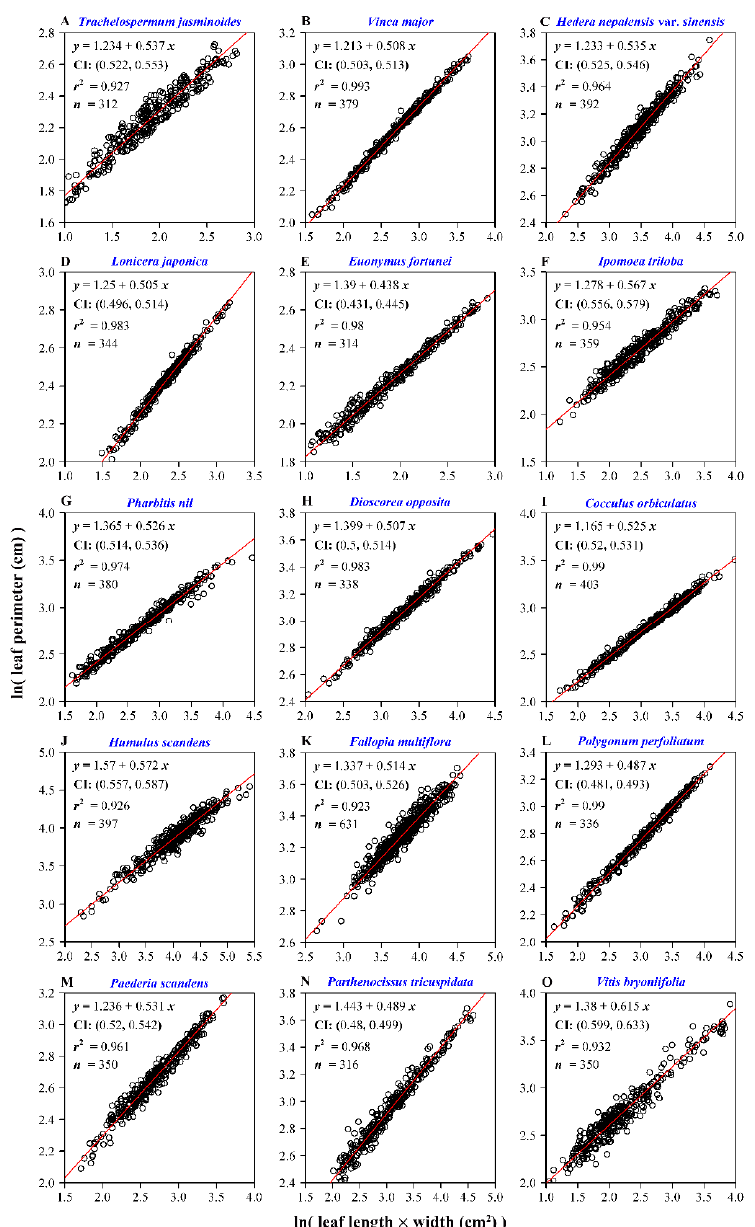
Figure 9. Scaling relationships between leaf perimeter and the product of leaf length and width for the 15 species of vines. Panels ( A − O ) represent different vine species. In each panel, y represents the natural logarithm of leaf perimeter in cm; x represents the natural logarithm of the product between leaf length and width in cm 2 ; CI represents the 95% confidence intervals of the slope based on bootstrapping (3000 resamples); r 2 is the coefficient of determination, which measures the goodness of fit for a reduced major axis regression; and n is the sample size (i.e., the number of data points).